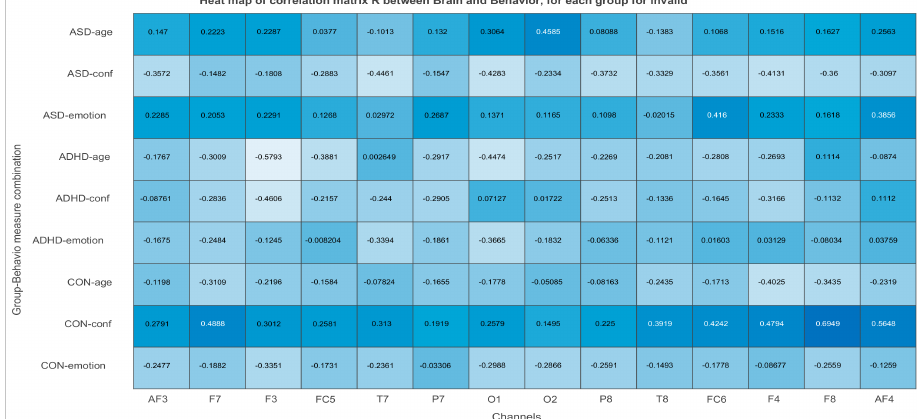
Figure 17. Heat map of the correlation matrix R between brain and behavior matrices for the invalid